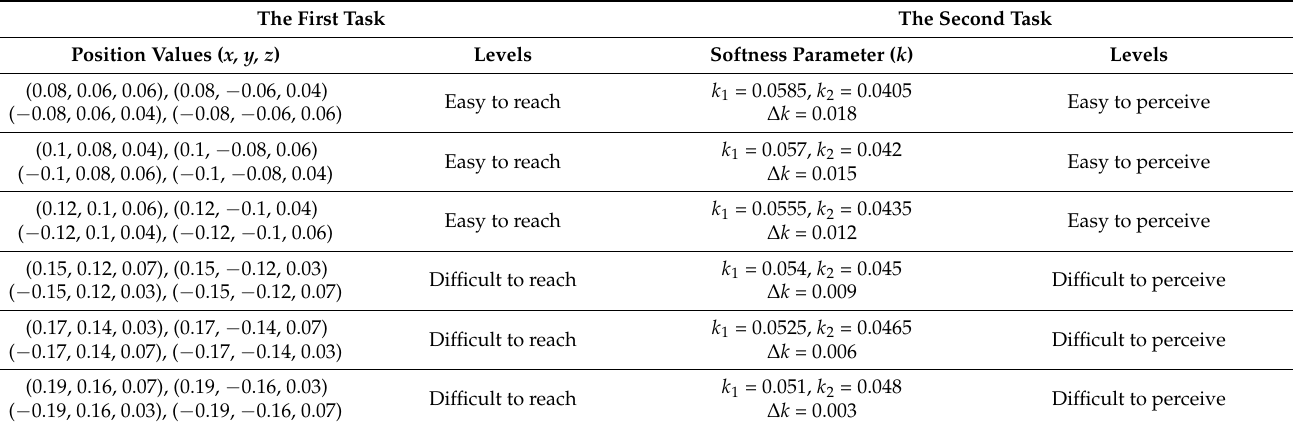
Table 1. Values for the parameters in the two experimental